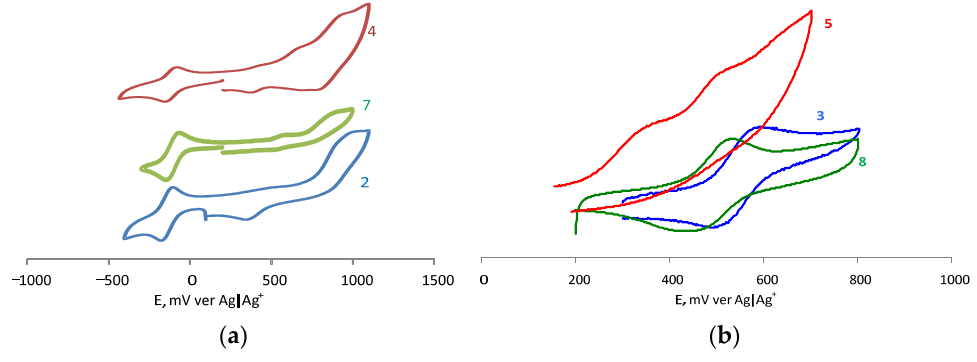
Figure 3. CVA curves recorded for ( a ) 17-e complexes 2 , 4 , 7 ; ( b ) 18-e complexes 3 , 5 , 8 . Table 2. The results of electrochemical studies of the obtained ruthenacarboranes 1